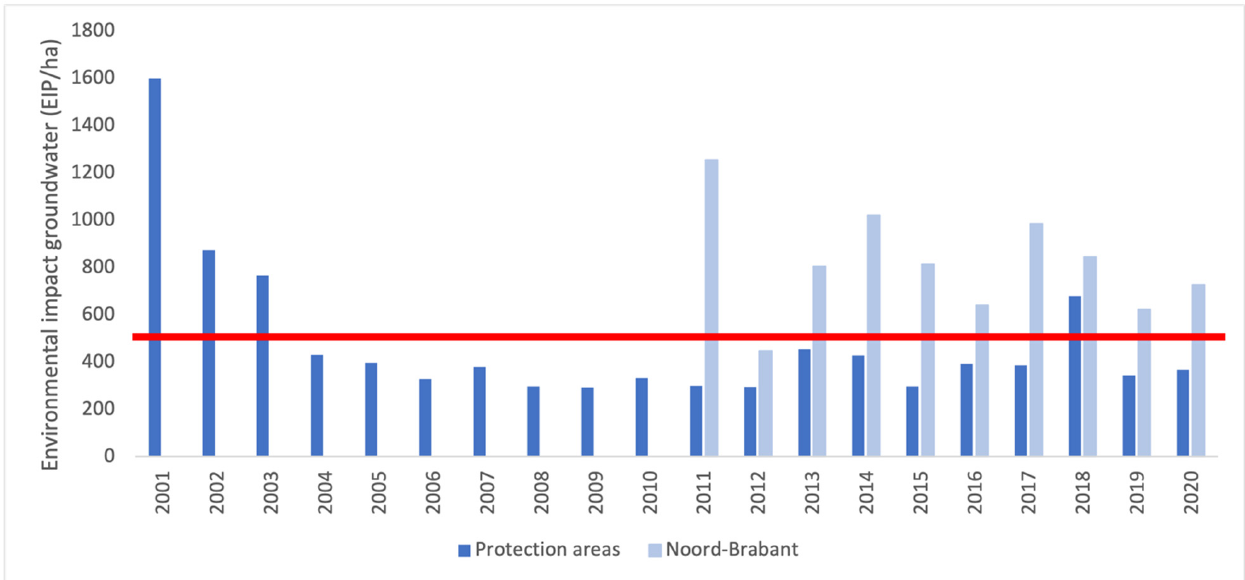
Figure 2. Environmental impact points (EIP/ha) within GWPAs and in the rest of Brabant between 2001 and 2020 for all crops. The red line indicates the target value of 500 EIP/ha.